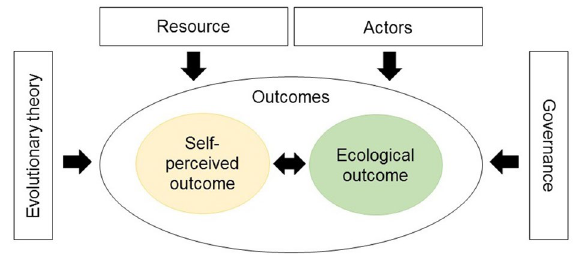
Figure 1. A simplified schematic diagram of the social-ecological system (SES) framework applied for urban gardening system in this study 3 . Sub-systems Actors, Governance, Resource and Evolutionary theory may influence the Outcomes, which itself is composed of Self-perceived and Ecological outcomes. The Self-perceived and Ecological outcomes may or may not be associated with each other in this system. To facilitate dialogue between evolutionary biology and SES literature and combine variables from somewhere between actors and governance, we treat Evolutionary theory as a